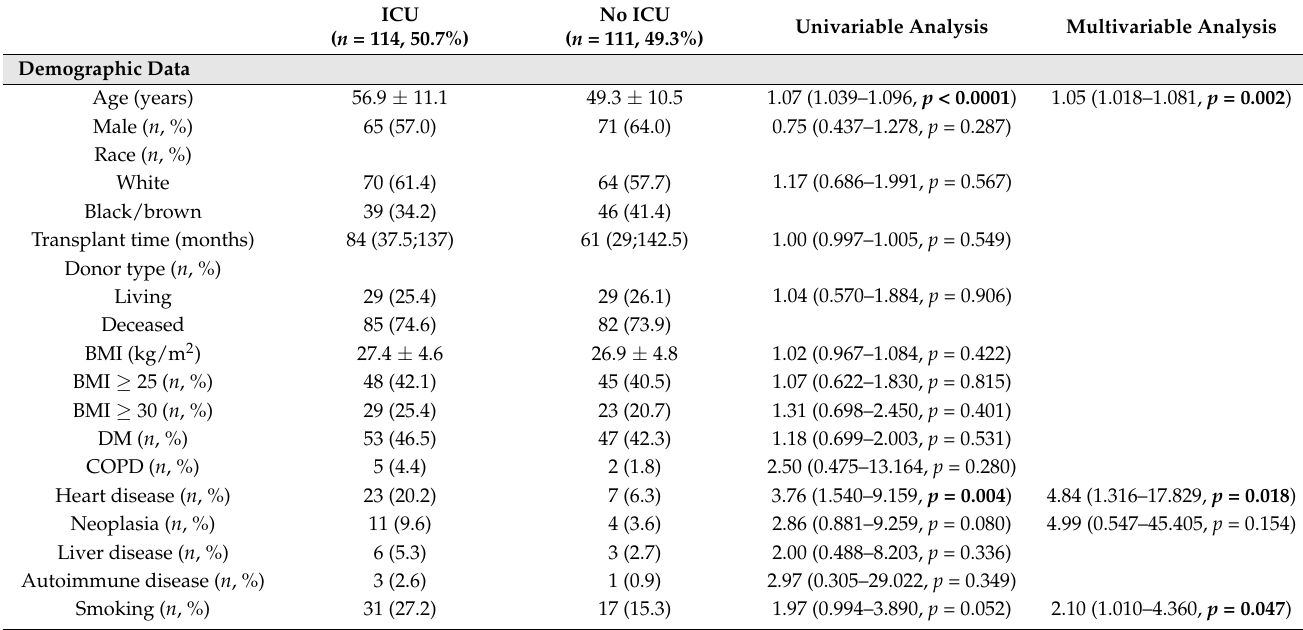
Table 3. Risk factors for intensive care unit (ICU) admission in kidney transplant recipients with hypertension (HTN). ICU ( n = 114, 50.7%)